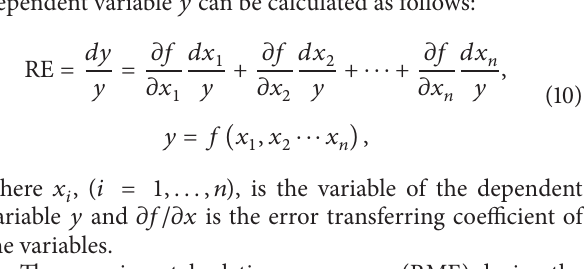
Figure 5: PV and thermal efficiency during the test.